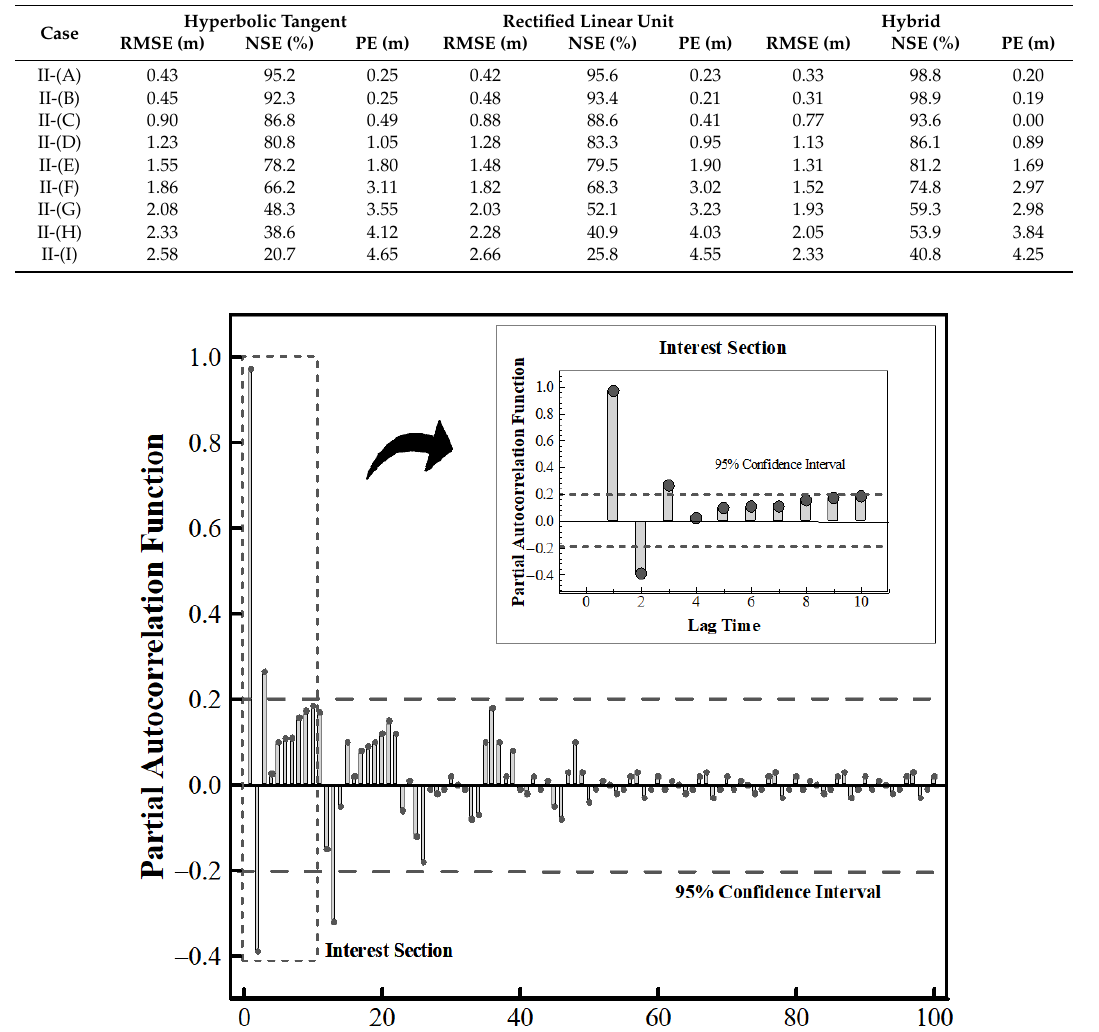
Table 11. Comparison of the accuracy in various activation function in Scenario II.